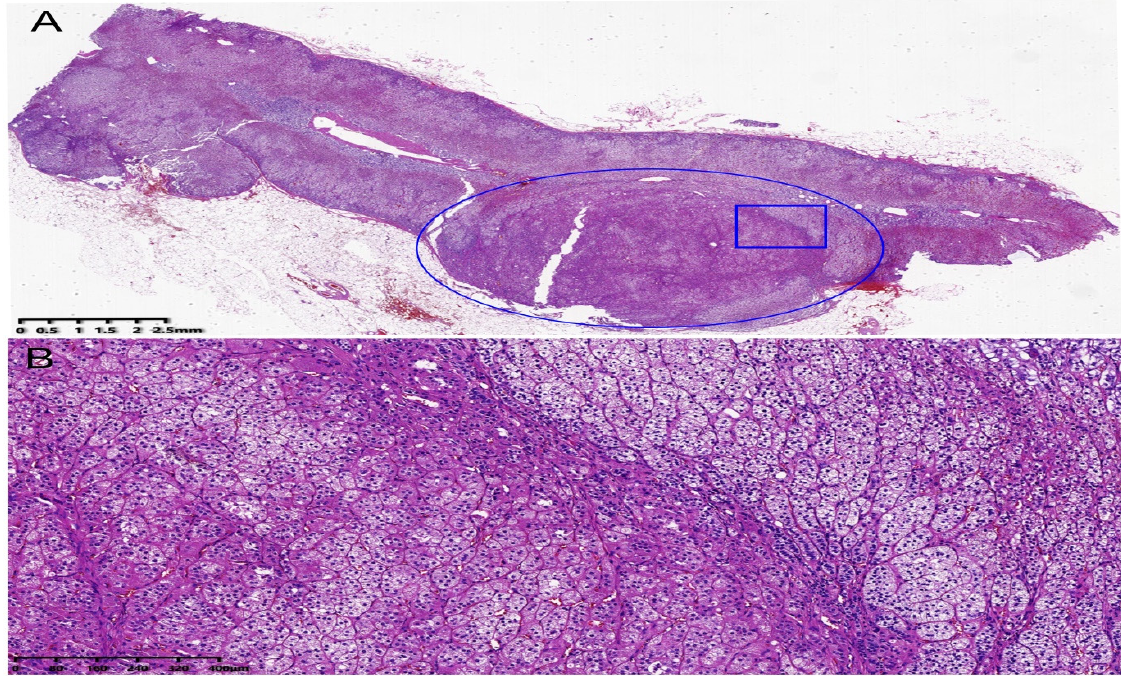
Figure 2. Histopathologic pictures of left adrenal gland. ( A ) Hematoxylin–eosin staining for left adrenal gland; the blue oval showed the left adrenal adenoma; the blue rectangle part of gland in ( A ) was magnified as shown in ( B ). ( B ) Hematoxylin–eosin staining showed fasciculata (ZF)-like cells, which were large, lipid laden clear, with round to oval vesicular nuclei, and zona glomerulosa (ZG)- like cells, characterized as small, compact cells, with high nuclear/cytoplasmic ratio and moderate amount of lipid.